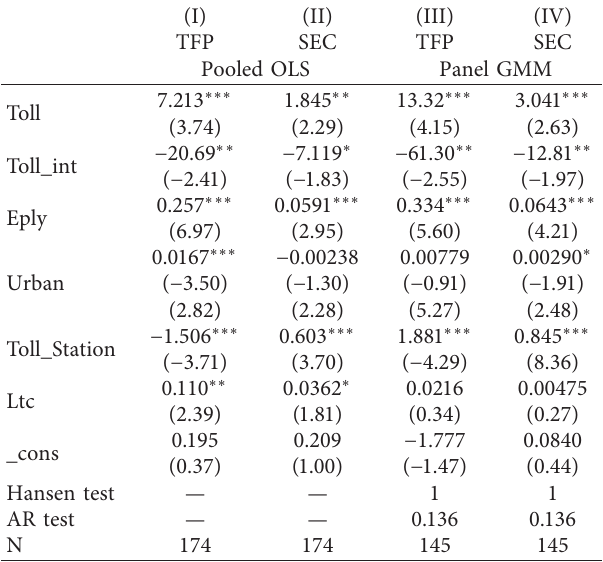
Table 8: Parameter estimation